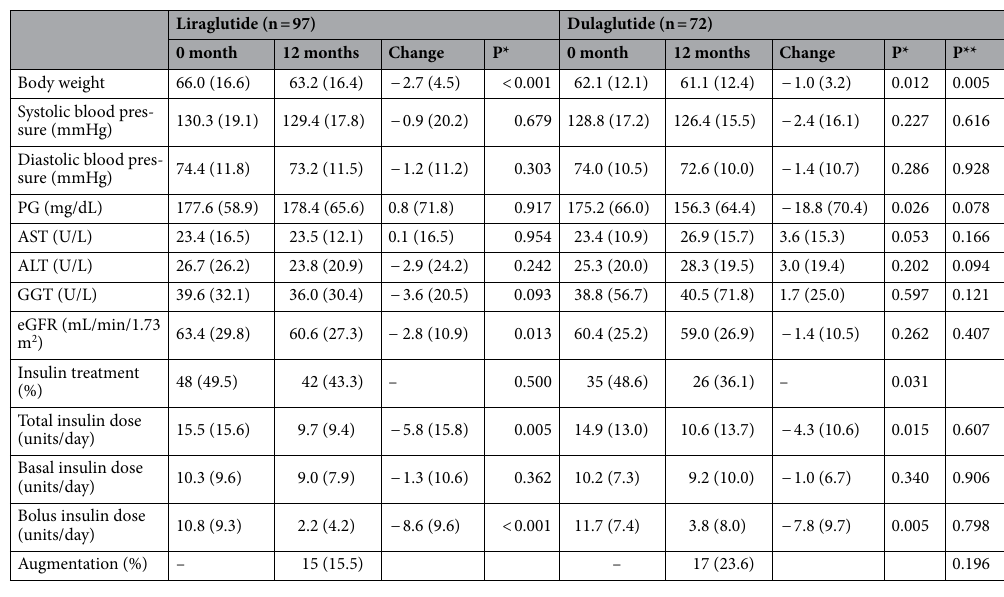
Table 2. Effects of treatment on various clinical and laboratory parameters after adjustment by stabilized propensity score-based IPTW. Data are mean (standard deviation), or n (%). PG plasma glucose, AST aspartate transaminase, ALT alanine transaminase, GGT gamma-glutamyl transferase, eGFR estimated glomerular filtration rate, IPTW inverse probability of treatment weighting. *P-value for comparisons between 0 and 12 months, by the paired t-test or Wilcoxon signed-rank test. **P-value for difference in changes from baseline between liraglutide and dulaglutide, by Student’s t-test or Wilcoxon rank sum test.